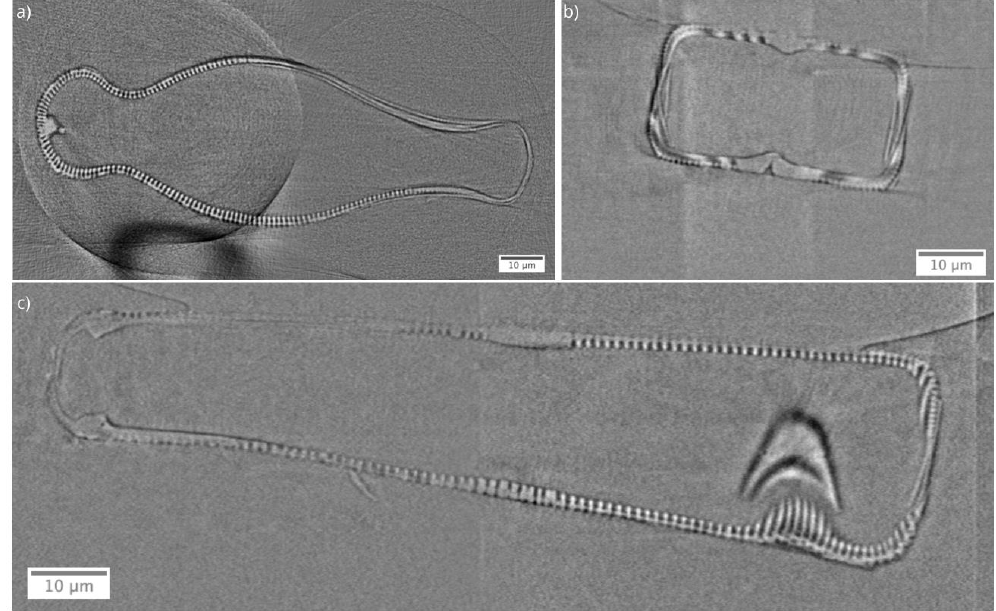
Figure 2. Virtual cross-sections from reconstructed nano-X-ray computed tomography data of the Didymosphenia geminata frustule. ( a ) XY slice, ( b ) XZ slice, and ( c ) YZ slice.